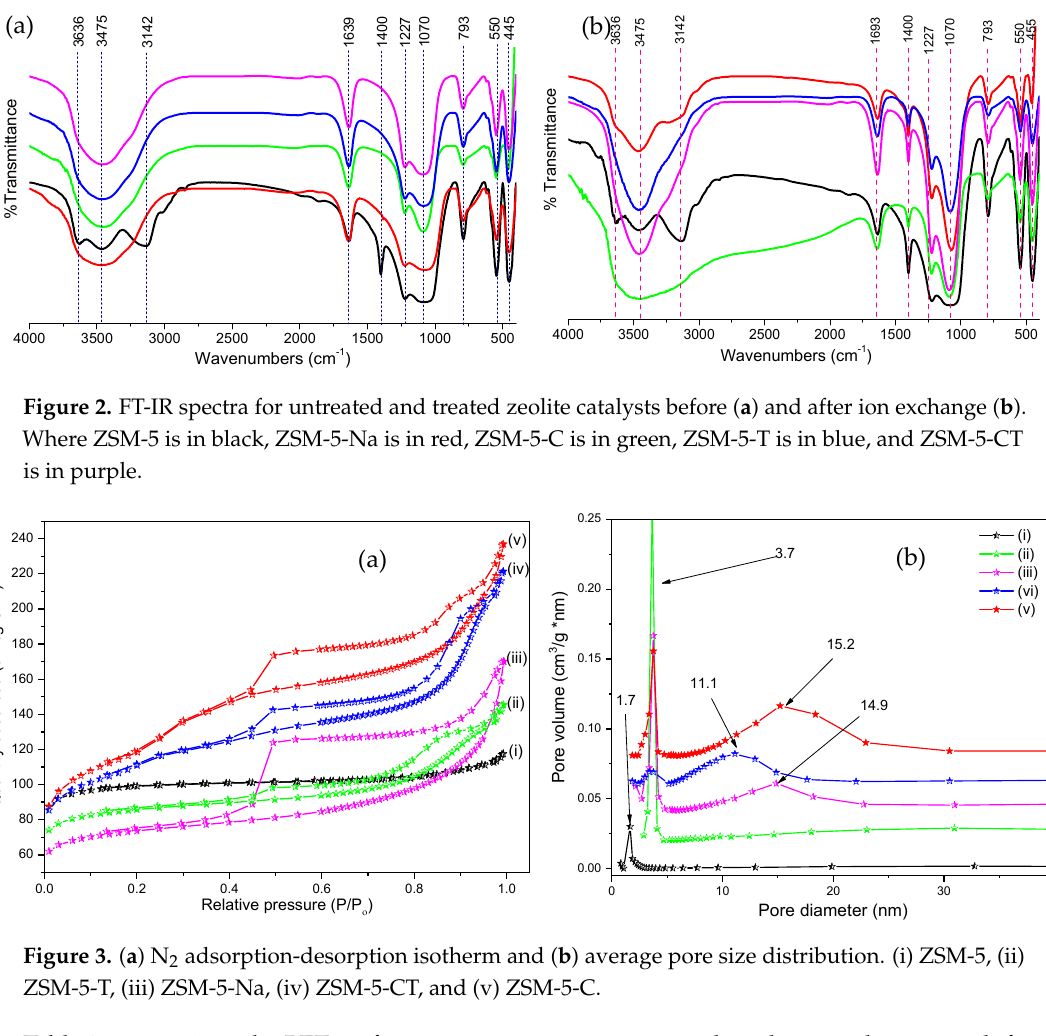
Table 3. N 2 adsorption ‐ desorption isotherms of untreated and treated zeolites.